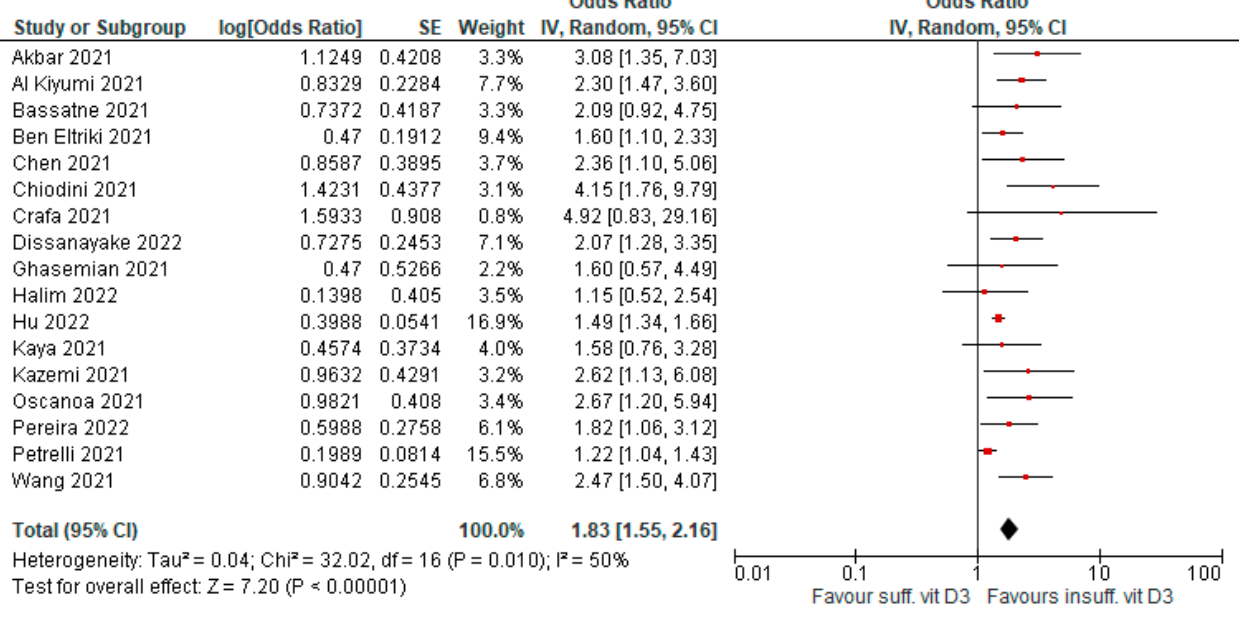
Figure 4. Forest plot showing results for the association of vitamin D3 levels and COVID-19 mortality.